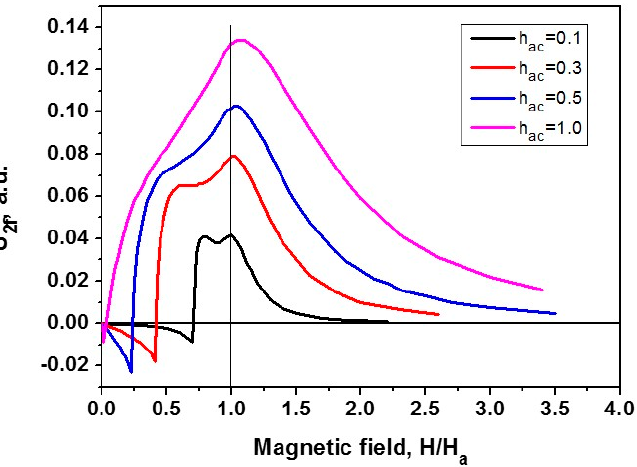
Figure 3. Fourier coefficient a 2 as a function of the dimensionless, longitudinal, magnetic field h , for the cases when H ac /H a = h ac = 0.1, 0.3, 0.5, and